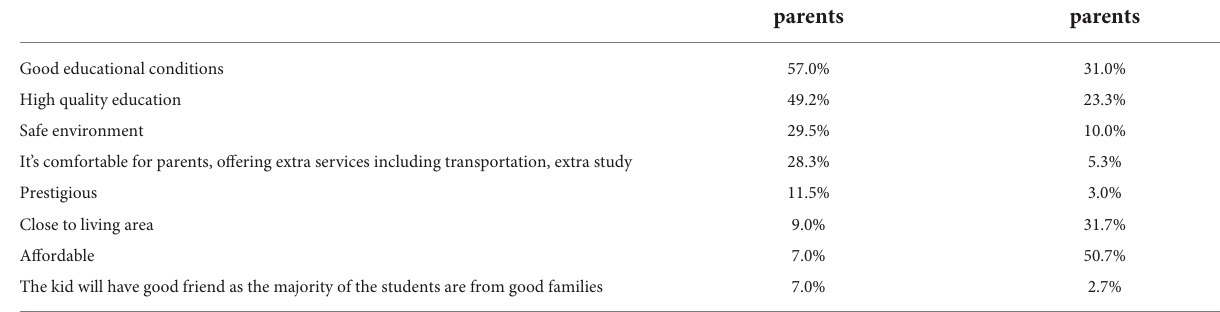
TABLE 9 Why did you choose the school named by